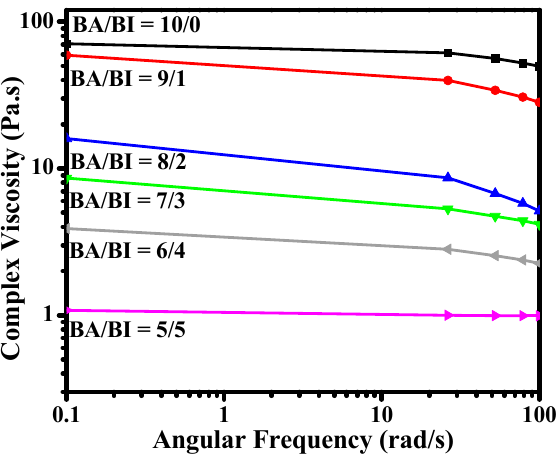
Figure 7. Complex viscosity of PBABI copolyesters with different BA/BI ratios as a function of angular frequency with 0.1–100 rad s − 1 at 80 °C.